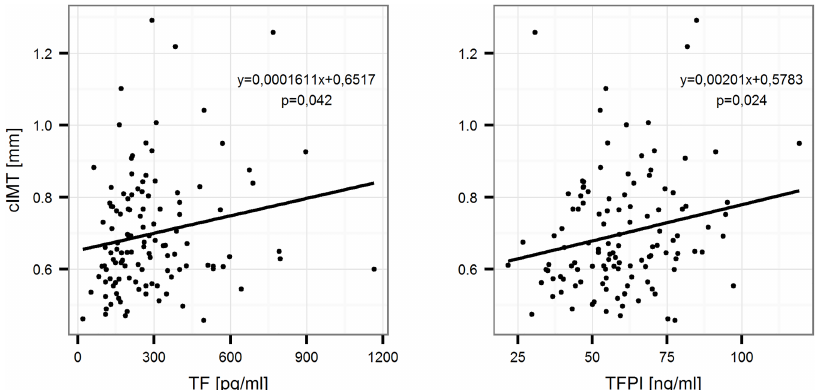
Fig 2. Linear relationship between the concentrations of TF and TFPI and the value of cIMT for the entire study group. Univariatelinear